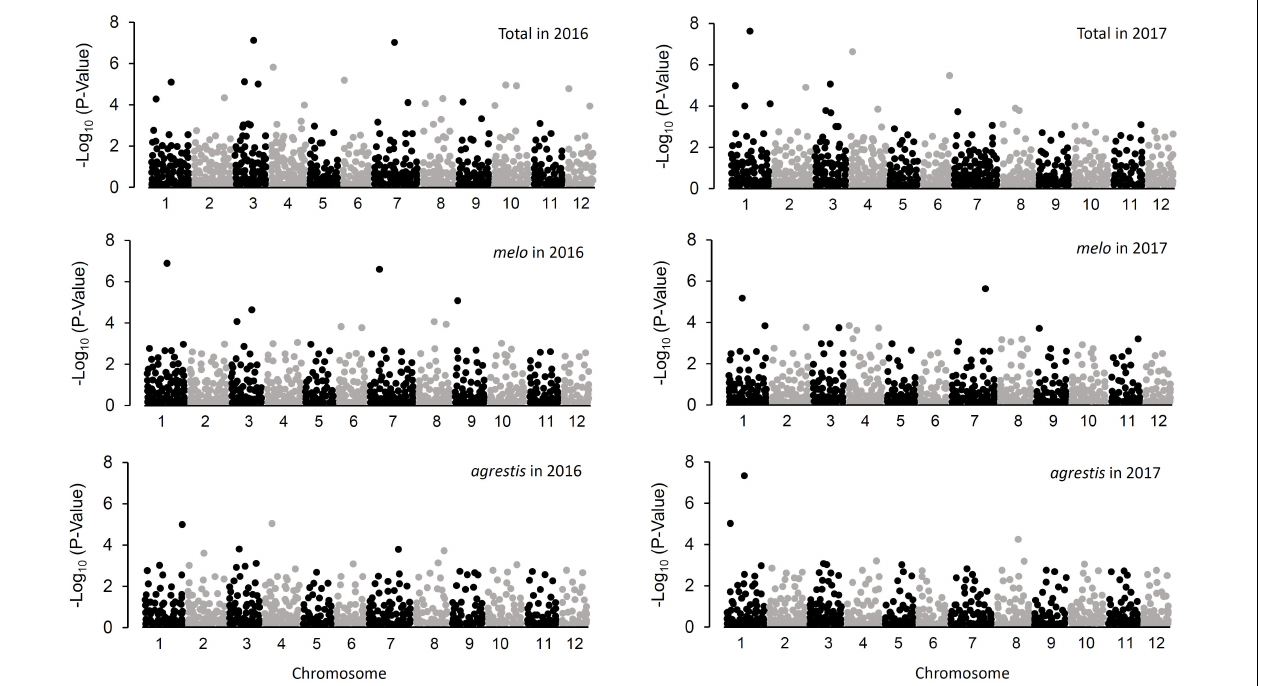
FIGURE 4 | Manhattan plots resulting from GWAS for CII values of melon